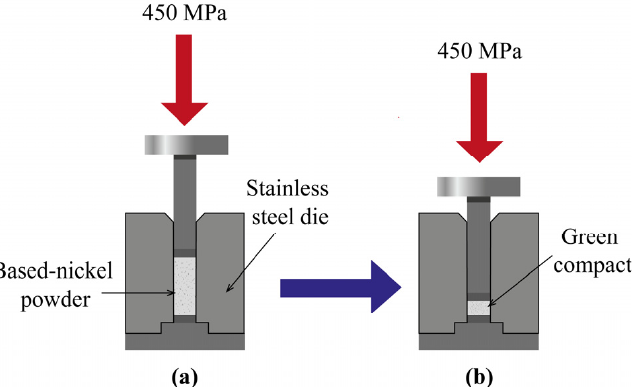
Figure 11. Schematic fabrication of green samples from Ni-based powders; ( a ) before pressed and ( b ) obtention of the green compact by 450 MPa of the applied load.